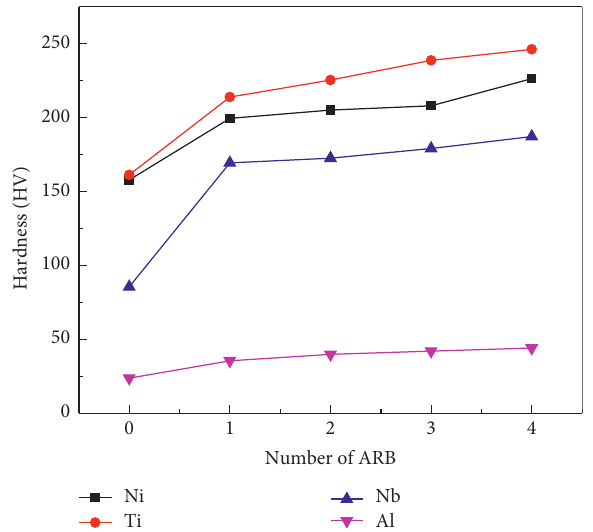
Figure 10: Variation of microhardness after different